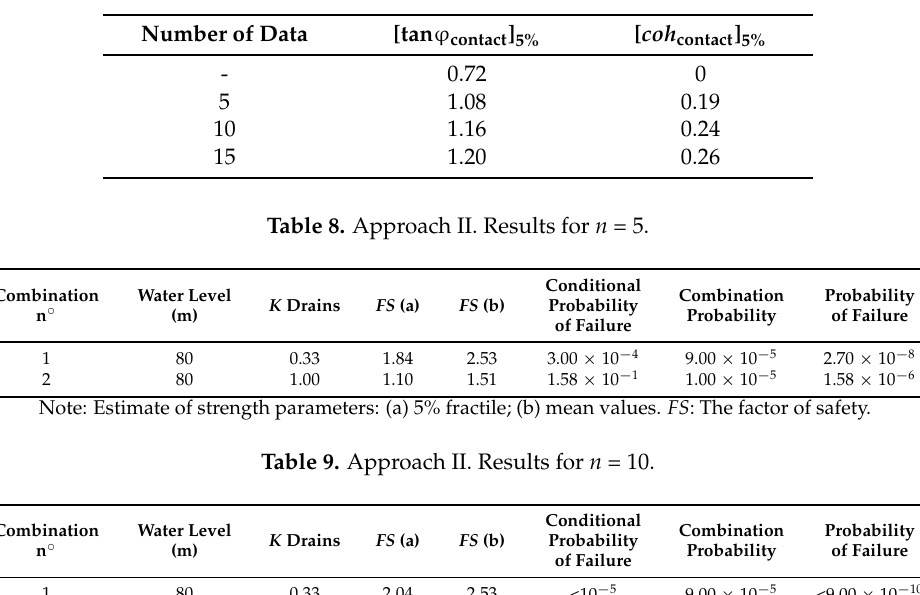
Table 7. Five percent fractile values for average strength parameters.